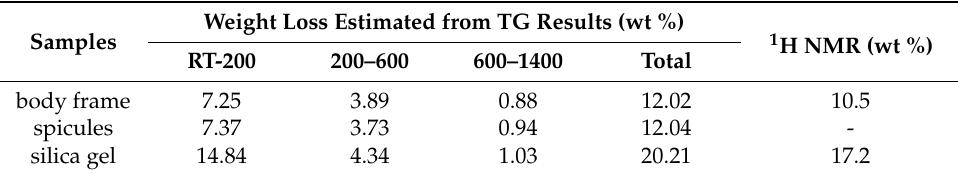
Figure 2. TG curves for body frame, spicules, and silica gel. Table 2. Water content of samples estimated from TG results and 1 H NMR spectra.